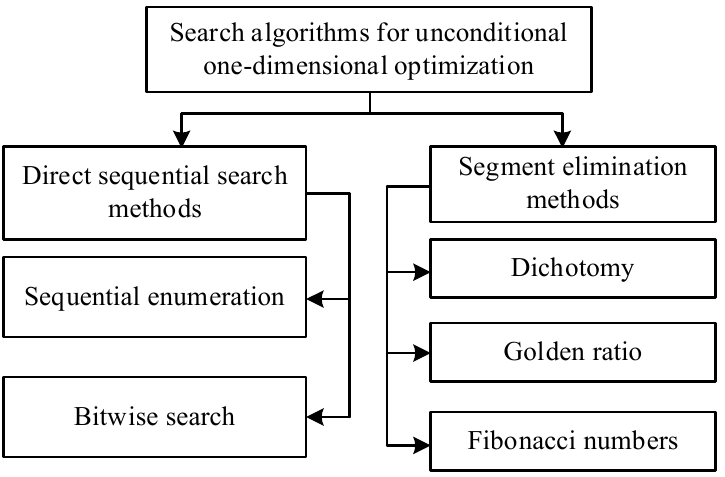
Figure 5. Classification of search algorithms for unconditional one -dimensional optimization.